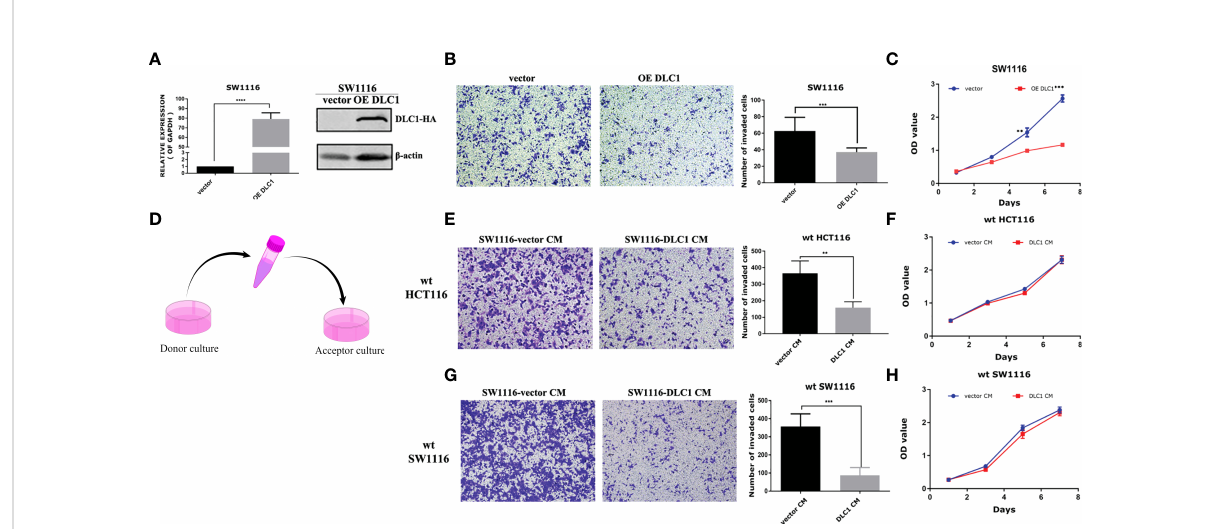
FIGURE 1 Culture medium of DLC1-overexpressed SW1116 cells inhibited the migration of wild-type colon adenocarcinoma cells. (A) We established a stable colon adenocarcinoma cell line with overexpression of DLC1 in SW1116 and con fi rmed by qRT-PCR and Western blot assays. The vector group cells were infected with non-target control virus. *** p < 0.001, compared with the vector group. (B) Overexpressed DLC1 inhibited migration of SW1116. *** p < 0.001, compared with the vector group. (C) Overexpressed DLC1 inhibited proliferation of SW1116. ** p < 0.01, *** p < 0.001, compared with the vector group. (D) The way we collected and concentrated DLC1-overexpressed SW1116 cells ’ CM to culture wild-type colon cell lines SW1116 By Figdraw and HCT116. Wild-type colon adenocarcinoma cell lines SW1116 (E) and HCT116 (G) cultured by DLC1-overexpressed CM (1 m g/ml) resulted in a signi fi cant reduction in cell migration. ** p < 0.01, *** p < 0.001, compared with the vector group. SW1116 (F) and HCT116 (H) cultured by DLC1-overexpressed CM (2 m g/ml) had no changes in cell proliferation as compared with vector control